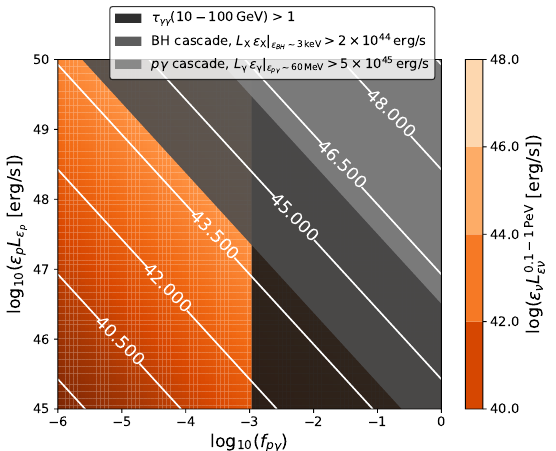
Figure 2. Maximum all-flavor neutrino luminosity, ε ν L 0 . 1 − 1 . 0PeV (white contour lines), in the ∼ 0 . 1 − 1 PeV energy range as a func- tion of the injected proton luminosity, ε p L ε production e ffi ciency from p γ interactions, f p γ , in a single-zone model for the 2017 flare of TXS0506 + 056, for protons with en- ergy ε p ∼ 20 ε ν . The region where f p γ > 10 − 3 (black) is excluded by the observation of > 100 GeV photons from TXS0506 + 056 during the 2017 flare. Mid-dark grey shows the region ruled out by the X-ray cascade constraint (eq. 18) and the lighter grey by the γ -ray cascade constraint (eq. 19).